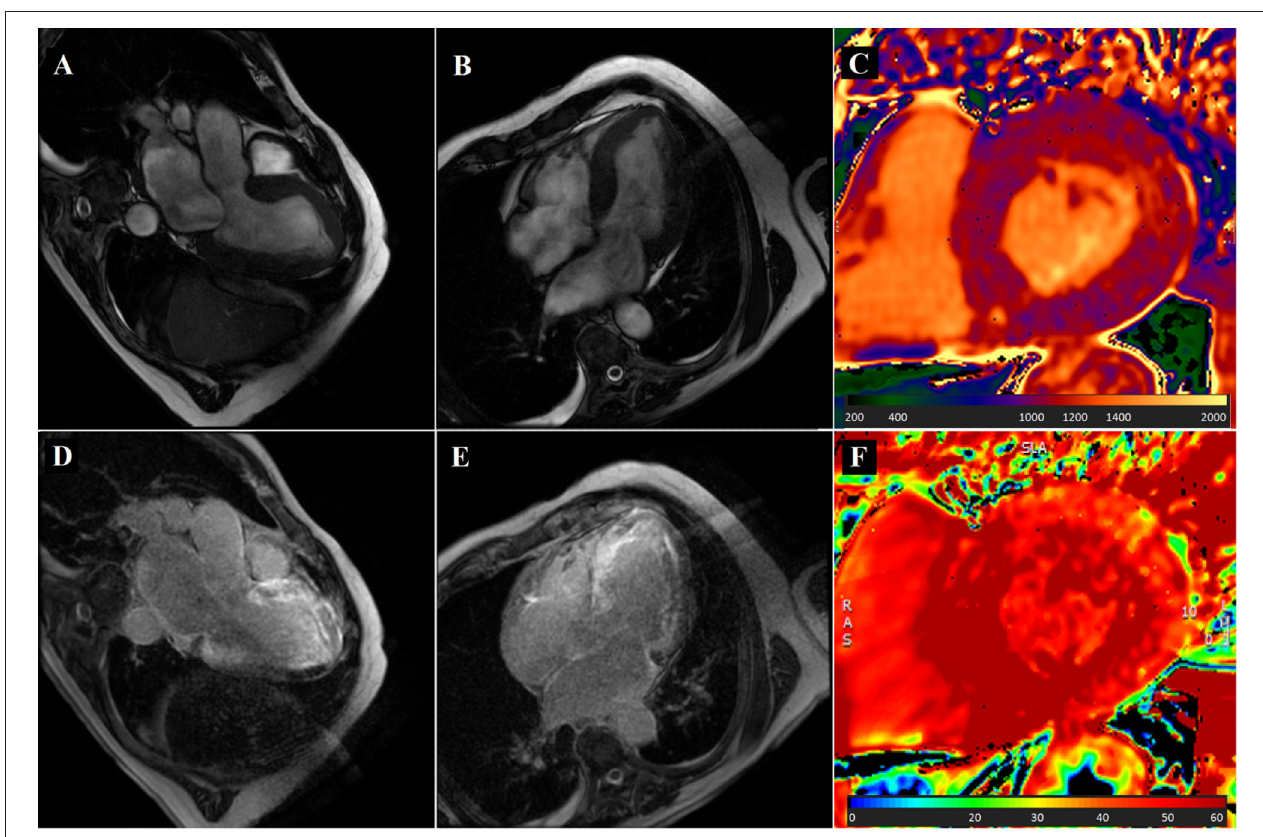
FIGURE 3 | Cardiovascular magnetic resonance (CMR) in a patient with dyspnea and cardiac amyloidosis. An 80-year-old man with a history of ischemic heart disease was referred to the cardiology clinic because of dyspnea. Clinical examination was unremarkable. CMR showed increased left ventricular wall thickness [ (A,B) , bSSFP images showing three- and four-chamber view respectively], increased left ventricular mass (115.9 g/m 2 ), and small pleural and pericardial effusion. Native T1 values were significantly increased, up to 1,200ms (C) . Late gadolinium enhancement showed diffuse left ventricular subendocardial enhancement, also involving the atria [ (D,E) , three- and four-chamber view, respectively]. ECV was markedly increased (F) . Patient was diagnosed with cardiac